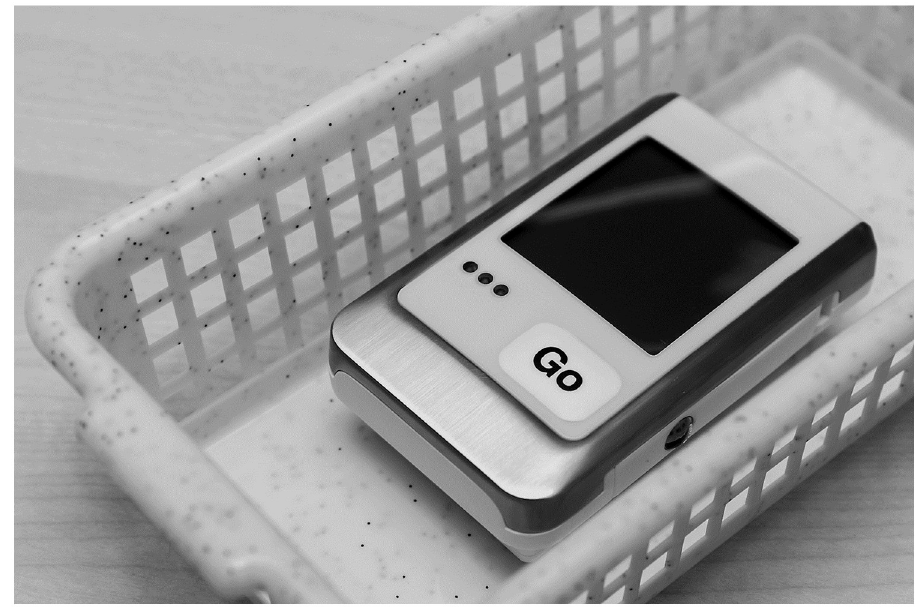
Fig 1. Set-up of data logger in plastic